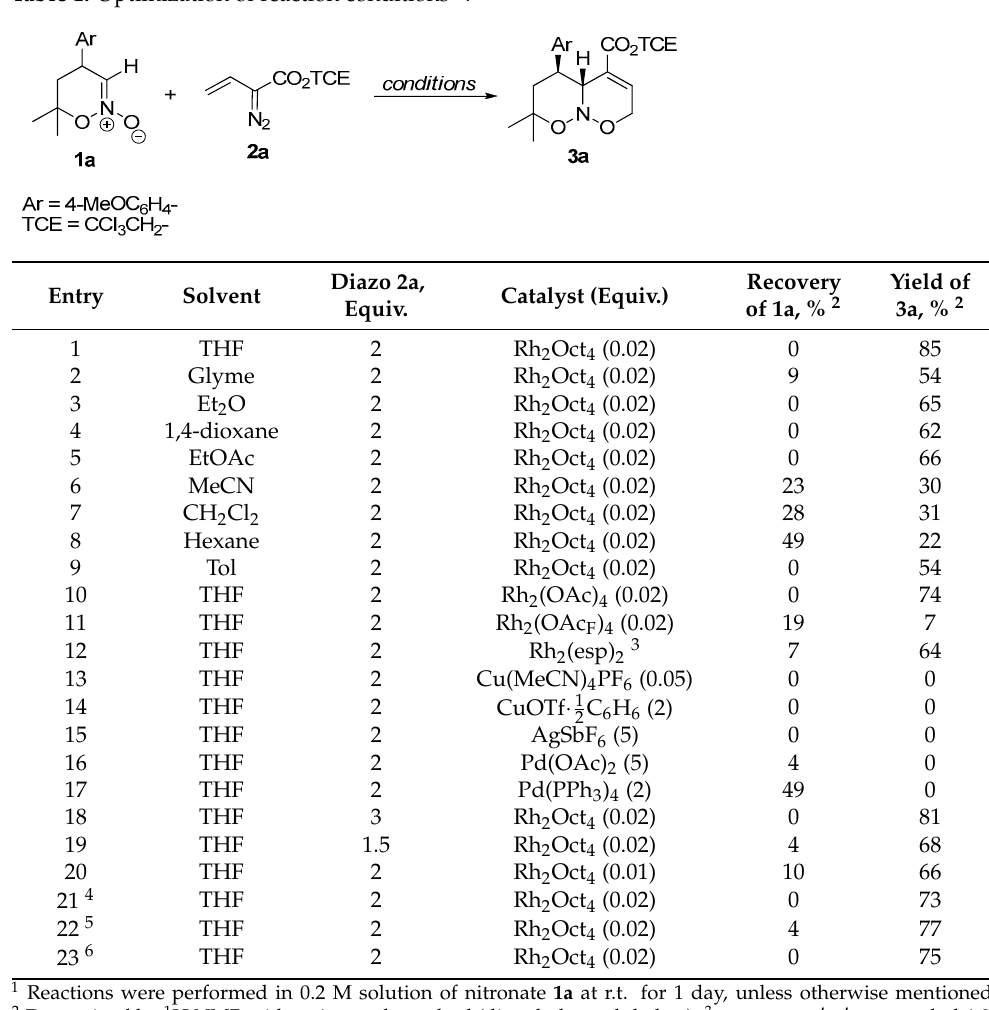
Table 1. Optimization of reaction conditions 1 .